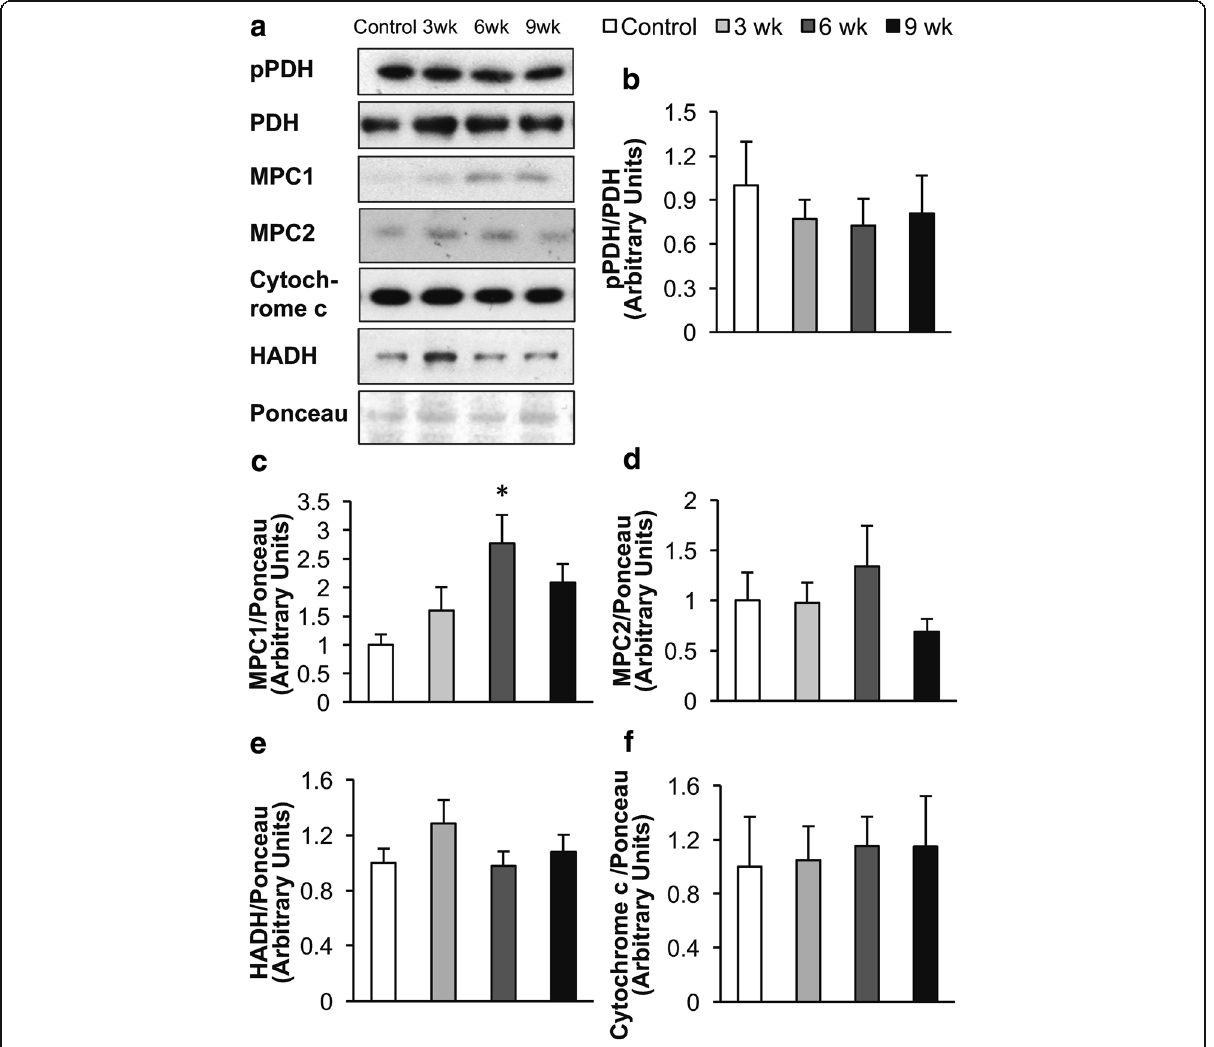
Fig. 4 Effect of a high salt diet (HSD) on the cardiac expression of proteins involved in oxidative metabolism. a Representative western blots. b pPDH Ser293/PDH, ( c ) MPC1, ( d ) MPC2, ( e ) HADH, and ( f ) cytochrome c protein expression was measured in hearts from Dahl salt-sensitive rats fed a low salt diet, 0.3% NaCl (Control) or a HSD, 8% NaCl, for 3, 6, or 9 weeks. n =4 – 9 * p <0.05 compared to Control. Values shown as mean ±